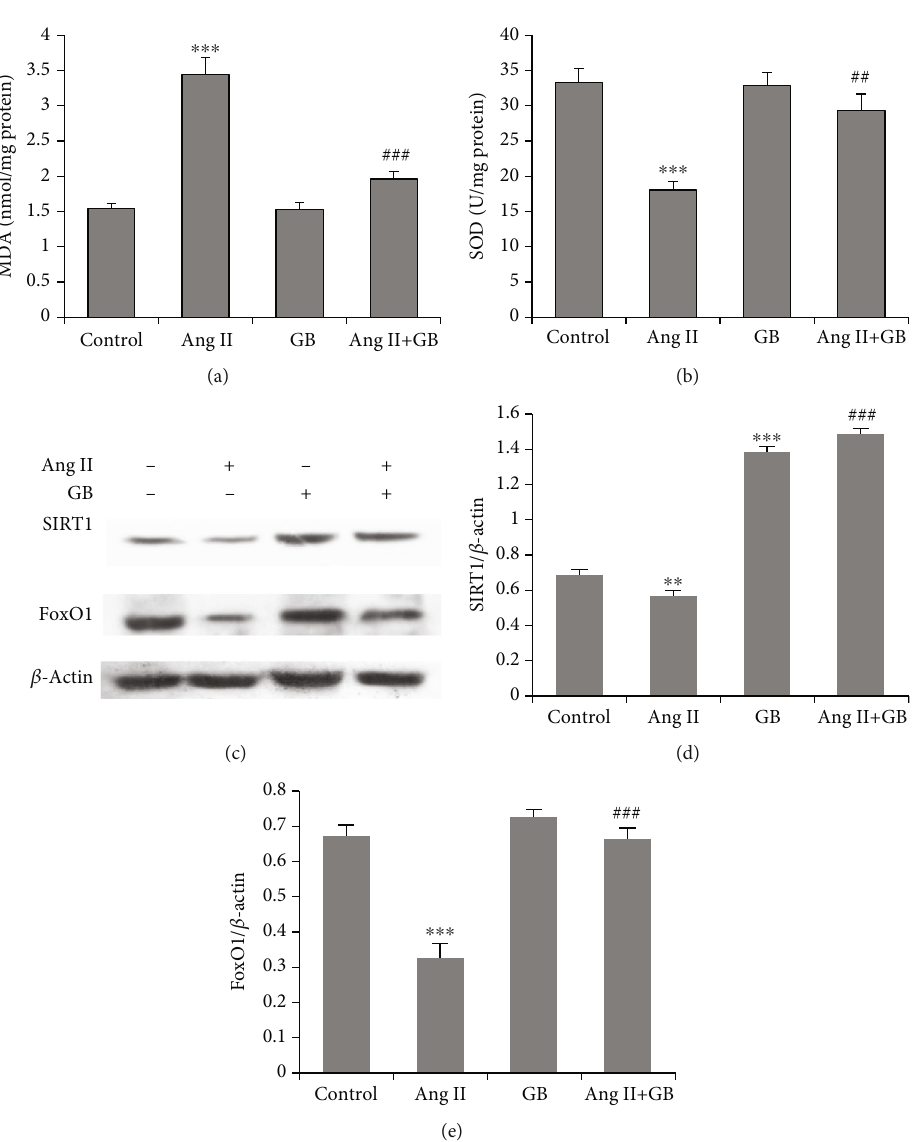
Figure 3: E ff ect of Ginkgolide B on oxidative stress and the SIRT1-FoxO1 pathway in Ang II-induced cardiomyocytes. Oxidative stress markers are measured, including MDA content (a) and SOD activity (b) in H9c2 cells. (c) Representative blots of protein levels of SIRT1 (d) and FoxO1 (e) are shown. ∗∗ P < 0 : 01 , ∗∗∗ P < 0 : 001 vs. the control group; ## P < 0 : 01 , ### P < 0 : 001 vs. the Ang II